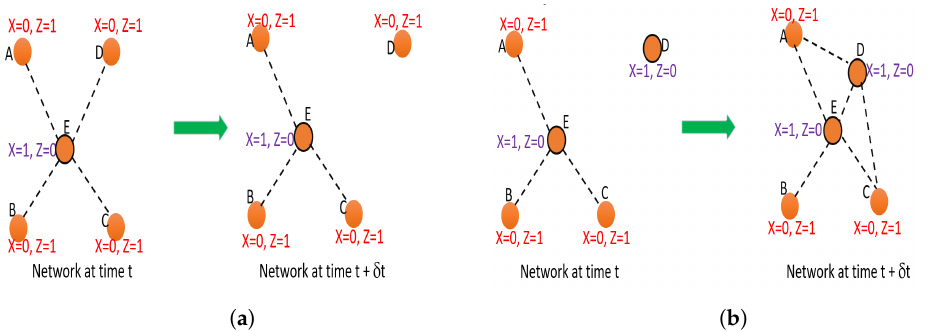
Figure 3. Demonstration of problems that arise if data collection is not optimized when the network topology changes; ( a ) Network instances showing data loss of broadcasting nodes due to isolation; ( b ) Network instances showing redundant data collection by agent nodes due to an agent moving to the neighborhood of another